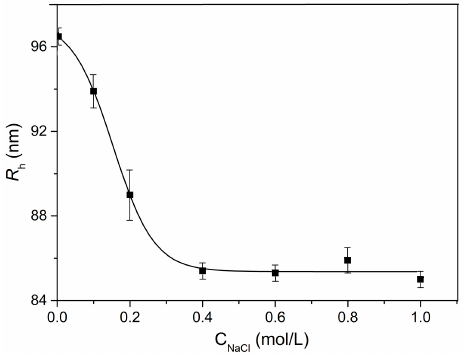
Figure 9. The effect of NaCl concentration on R h of polymeric micelles at pH = 1.5.